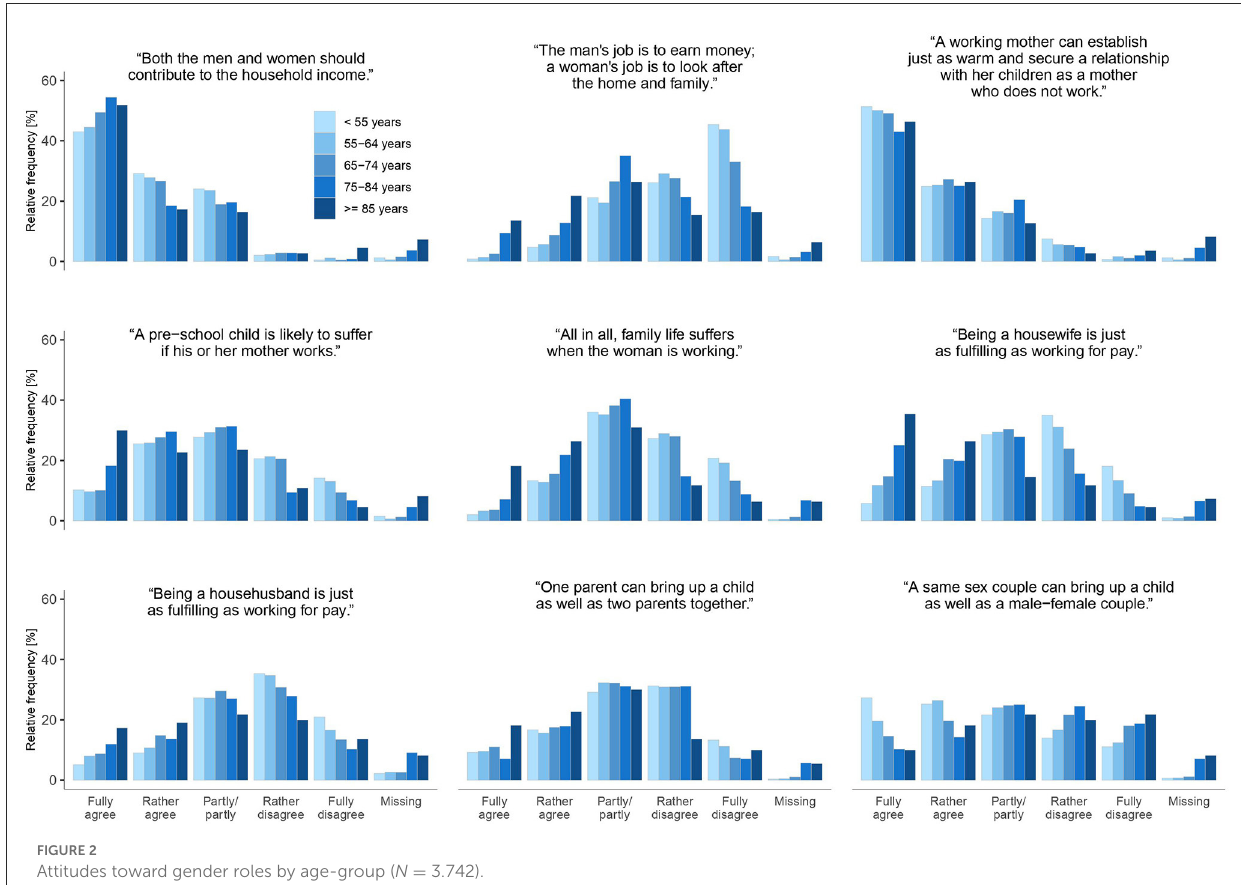
FIGURE2 Attitudes toward gender roles by age-group ( N = 3.742).